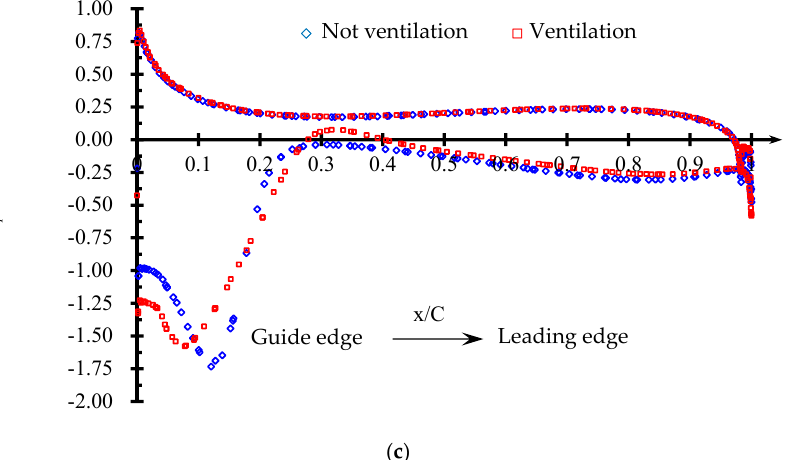
Figure 10. The pressure distribution profiles at J = 0.85. ( a ) The pressure distribution profile at 0.24 R ; ( b ) The pressure distribution profile at 0.50 R ; ( c ) The pressure distribution profile at 0.70 R.